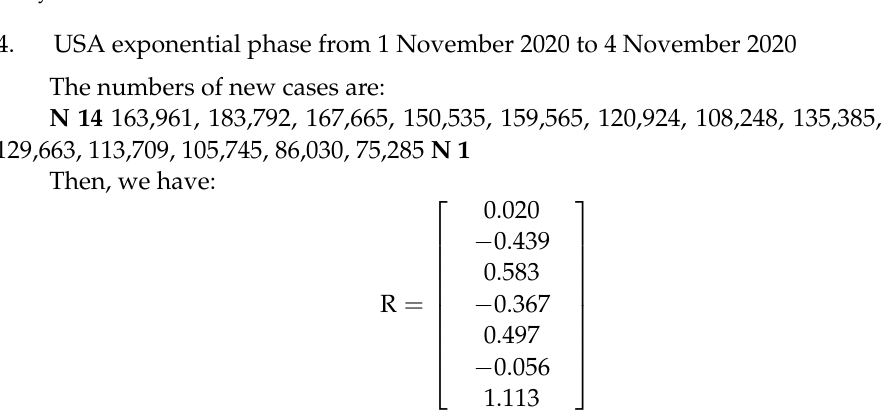
Figure A4. Values of the daily reproduction numbers R j along the period of contagiousness of length 7 days.